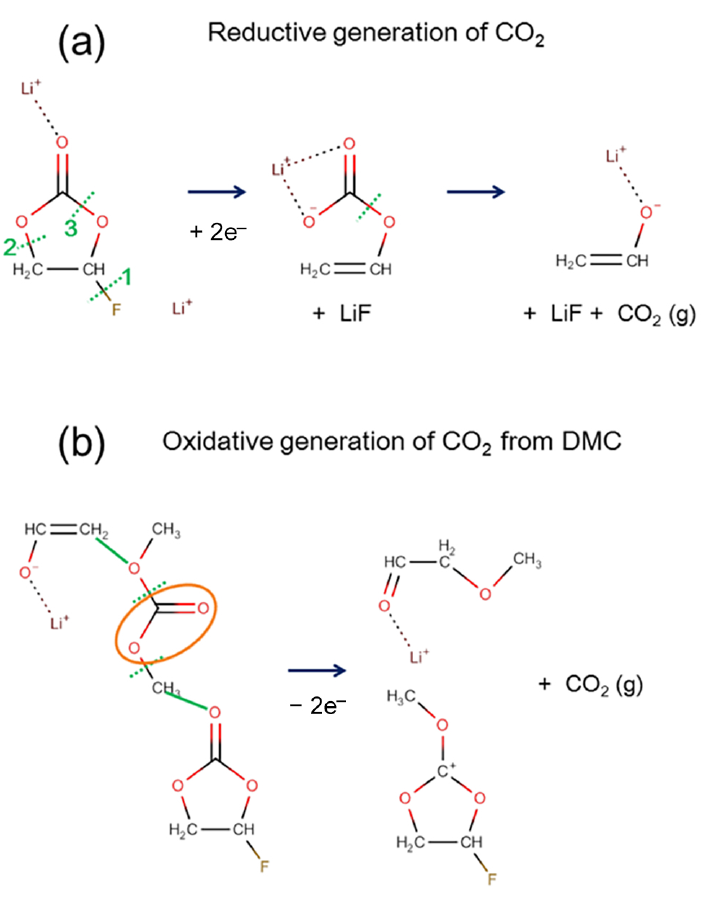
Figure 6. Reactions of CO 2 gas generation were observed through AIMD modeling. Both the ( a ) reductive reaction and ( b ) oxidative reaction produced molecular CO 2 . Overall, the CO 2 generation reactions were observed much more frequently in the electrolyte without the DVSF additive. The majority of CO 2 gases were generated in the following oxidation rather than in the initial reductive process. The solid green lines indicate bond formation, and the dotted green lines indicate bond breaking. The atoms in the orange circle become a CO 2 gas molecule after an oxidative